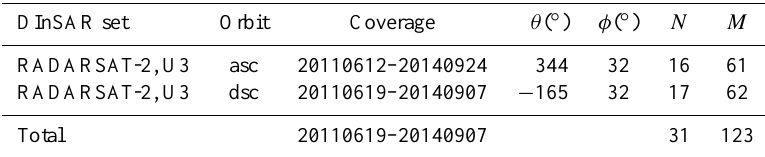
Table 1. RADARSAT-2 Ultra-Fine 3 (U3) Synthetic Aperture Radar images used in this study; θ is azimuth and φ is incidence angle, N is number of images, and M is number of interferograms computed for each data set. Time series span 19 June 2011–7 September 2014 interval when both ascending (asc) and descending (dsc) data are available. DInSAR set Orbit Coverage θ ( ◦